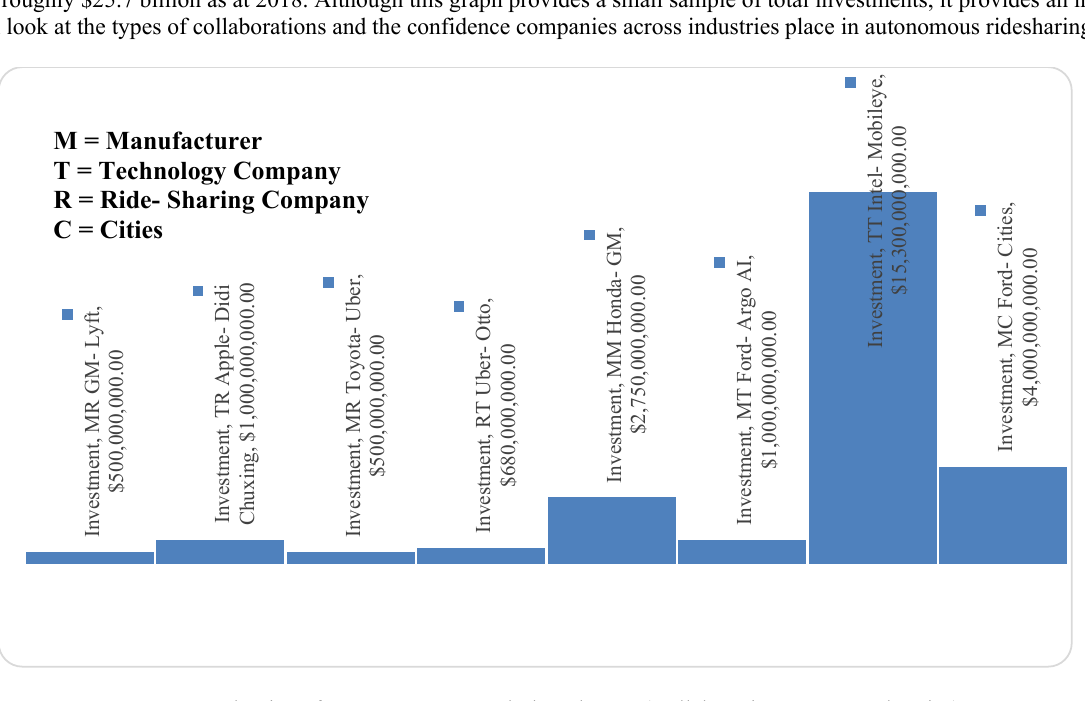
Fig. 1. Sample Size of Investments toward Shared AV's (Collaborations across